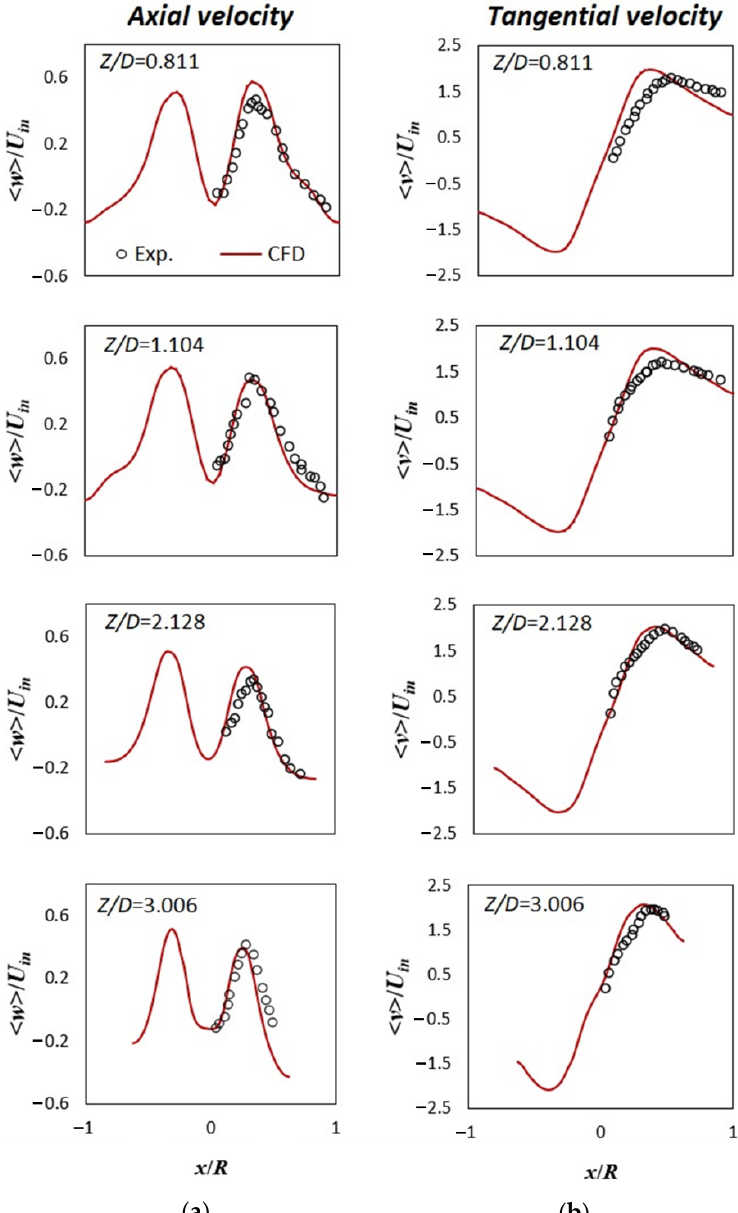
Figure 4. Comparative analysis of CFD results with experimental data [54]: ( a ) the first column— mean axial velocity; the second column—mean tangential velocity, and ( b ) from top to bottom: radial profiles at axial locations Z / D = 0.811, 1.104, 2.128, and 3.006 ( D = 2 R = 0.205 m is the barrel diameter) from the cyclone roof, respectively.